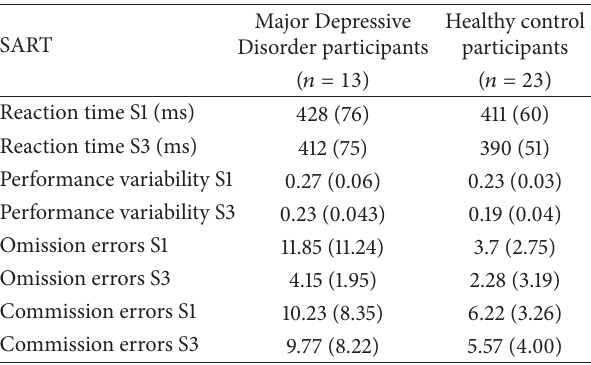
Table 3: Mean and standard deviation of long-term cognitive data of